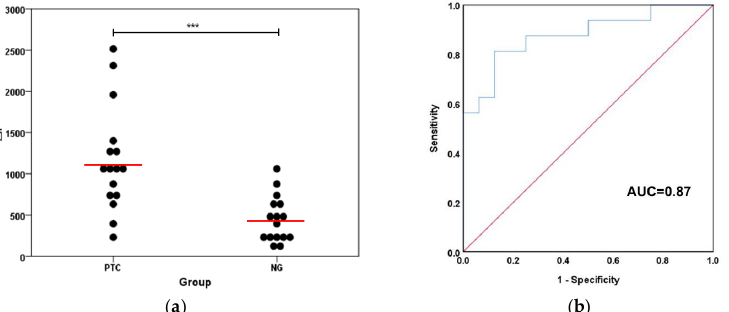
Figure 6. ( a ) The expression levels of hsa-miR-146b-5p in PTC tissues and NG tissues (the significance of data is analyzed according to two-sided unpaired Student’s t -test: *** p < 0.001); and ( b ) the corresponding receiver operating characteristic curve (ROC) curve generated on the basis of 32 clinical tissue samples.